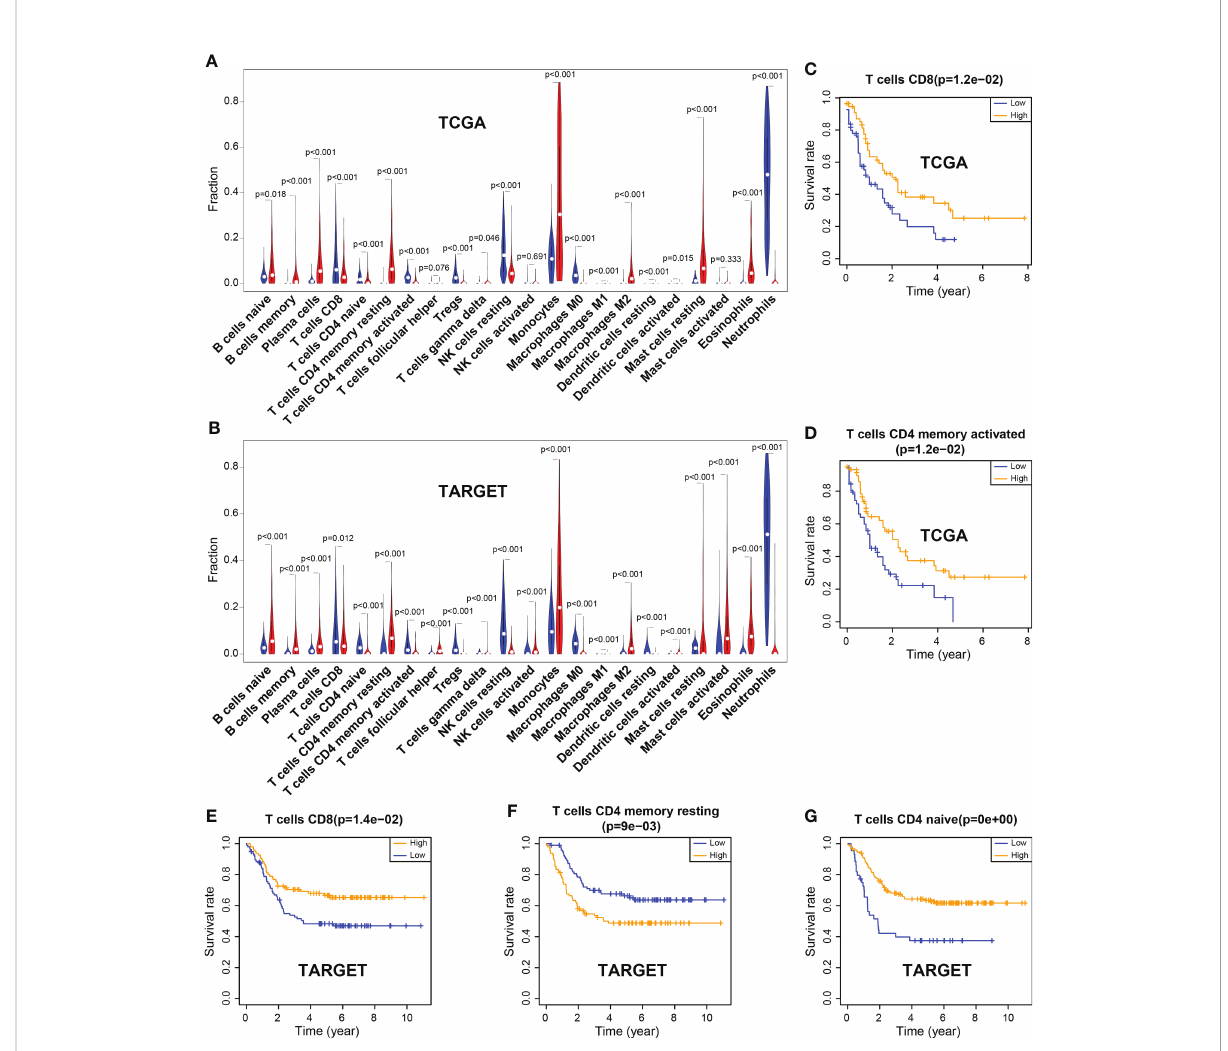
FIGURE 1 Differences of immune cell in fi ltration between the tumor and the normal group, and correlation between immune cells and the overall survival rate. (A) Violin plot of immune cell in fi ltration in TCGA. (B) Violin plot of immune cell in fi ltration in TARGET. (C, D) CD8 and activated memory CD4 T cells were associated with the overall survival (OS) rate, which was signi fi cantly higher in the high-level group than in the low-level group in TCGA. (E – G) CD8 T cells and naïve CD4 T cells were associated with the OS rate, which was markedly higher in the high-level group than in the low-level group in TARGET; however, resting memory CD4 T cells showed the opposite